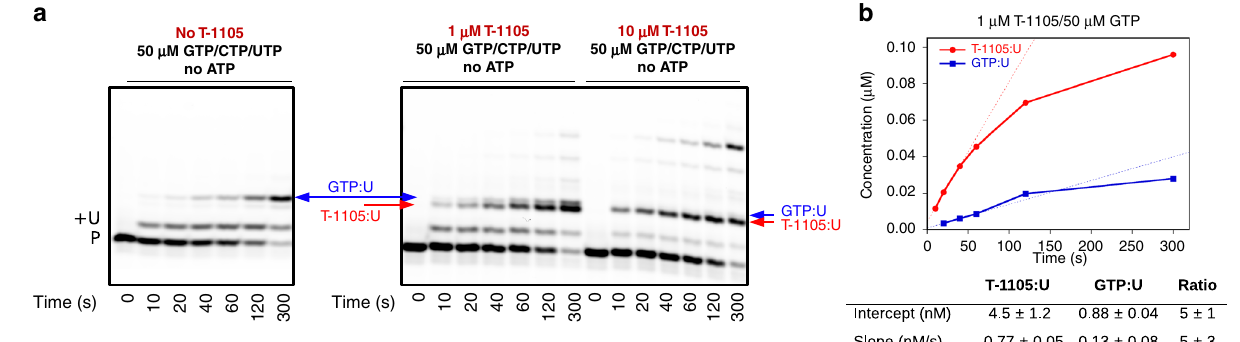
Fig. 4 Comparison of T-1105-RTP:U and natural GTP:U mismatch incorporation levels. a Elongation reactions with the PT substrate done in the absence of ATP with 50 µ M each GTP, UTP and CTP show rapid addition of the fi rst uracil followed by slow misincorporation of a GTP:U mismatch. In the presence of 1 µ M T-1105-RTP (with 50 µ M each GTP, UTP and CTP) the analogue incorporation is on a similar timescale as the native GTP:U mismatch. b Analysis of incorporation levels show a burst phase followed by linear product buildup over a 60-s timeframe that is consistent with the measured lifetime of the nsp12-7L8-8 elongation complex. Both the burst amplitude and linear rate indicate that 1 µ M T-1105-RTP is incorporated ~5-fold faster than the natural GTP:U mismatch at 50 µ M GTP. Quantitation re fl ects slopes and intercepts with standard errors obtained from a linear curve fi t to the initial rate data (0 – 60 s). Expanded concentration series shown in Supplementary Fig. 5b, bottom panel. Source data are provided as a Source Data fi le.